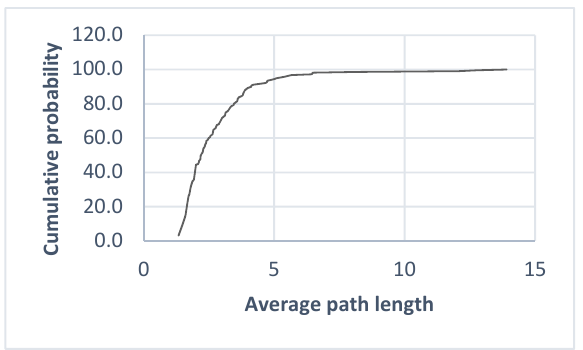
Figure 3. Cumulative probability distribution of the average path length.